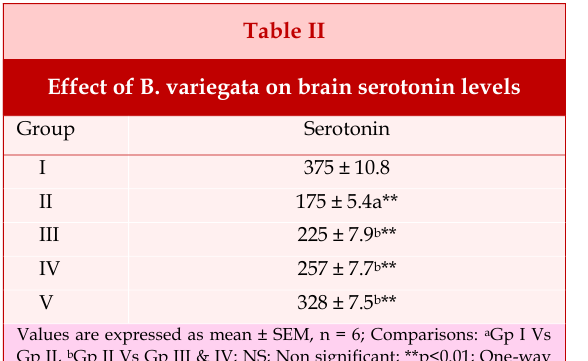
Figure 1: Body weight variation between animal